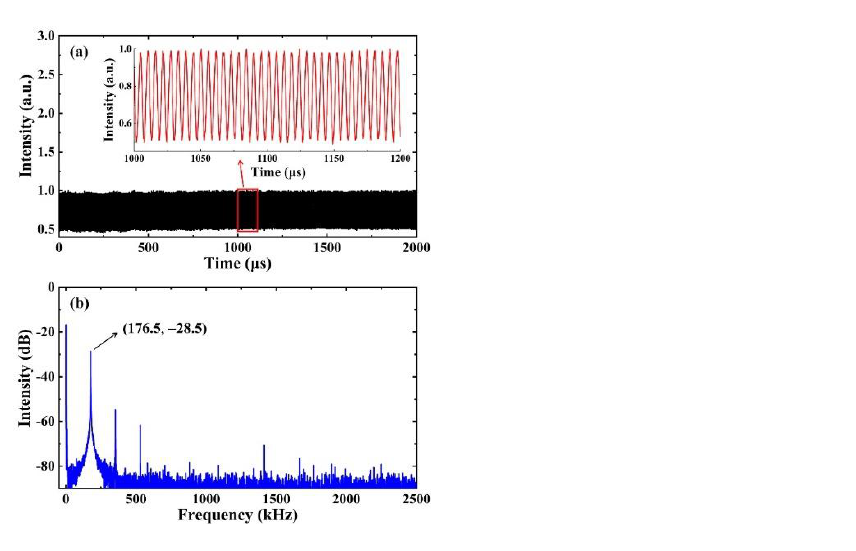
Figure 5. ( a ) Optical beats measured in the experiment after packaging. The inset is magnification of waveform; ( b ) Frequency spectrum of the optical